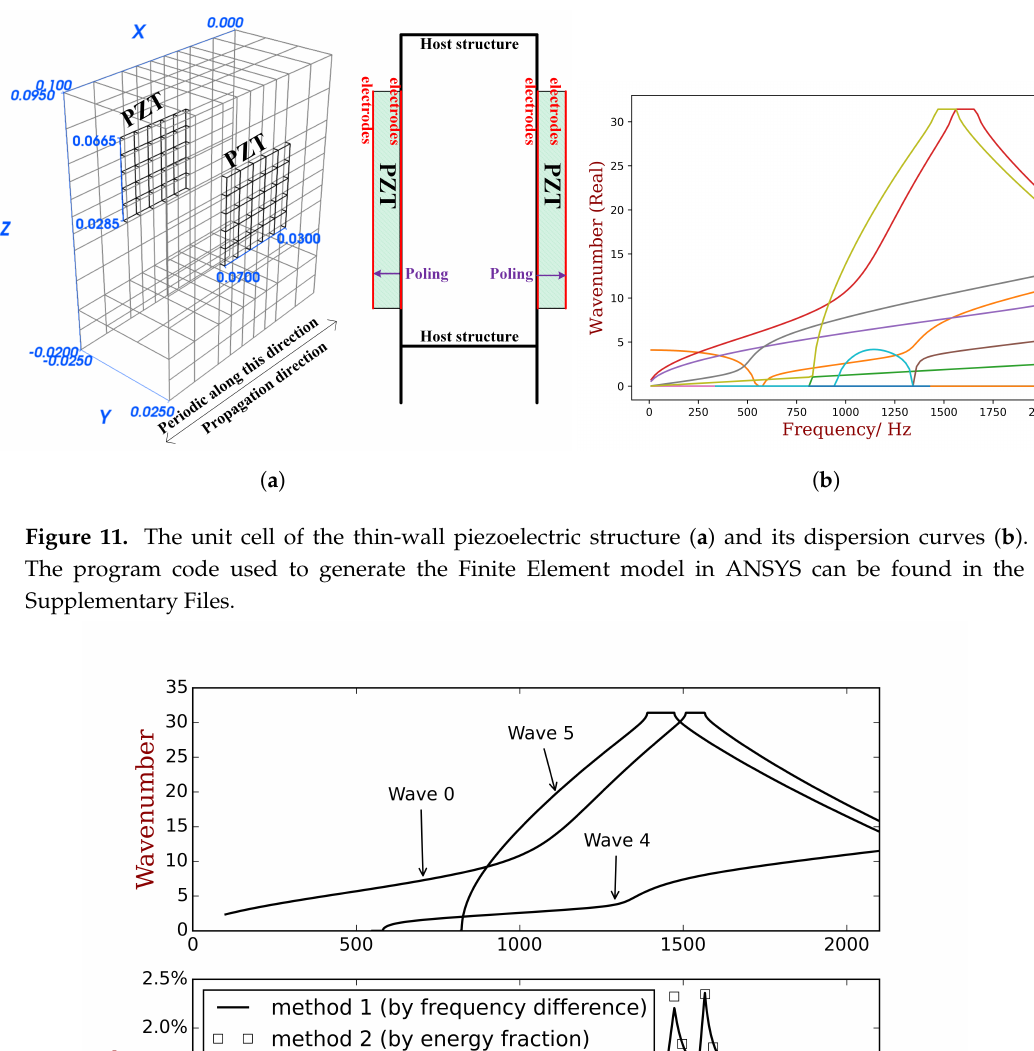
and the energy formula W is calculated 1f